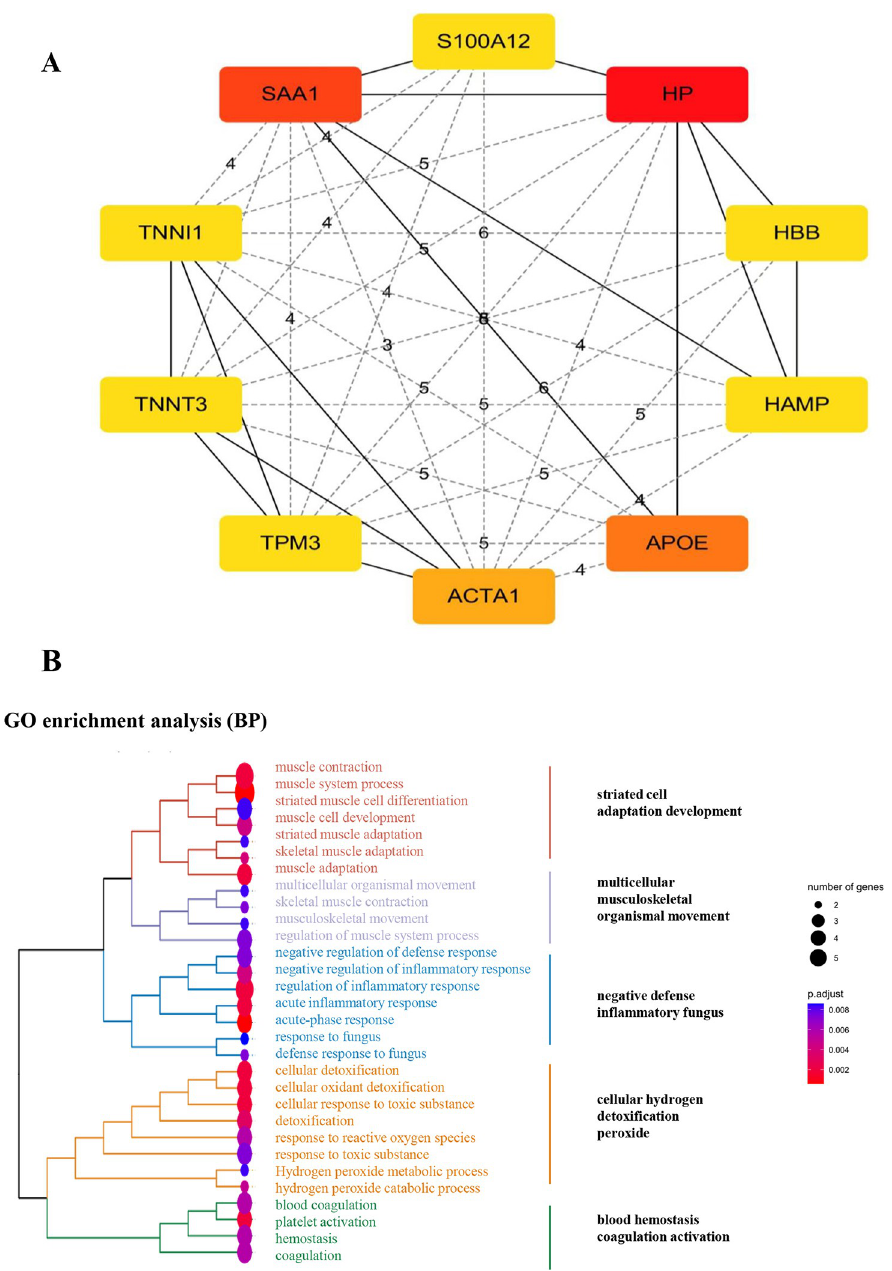
Fig 4. Identification of hug mRNAs. (A) It showed that 10 hub mRNAs with the highest degree identified according to the PPI network, which had critical roles in PPI network. (B) Functional prediction of hug mRNAs in PAH. analysed the GO terms of the hub mRNAs and found that they were predominantly concen- trated in striated cell adaptation development, multicellular musculoskeletal organismal move- ment, negative defense inflammatory fungus, cellular hydrogen detoxification peroxide and blood hemostasis coagulation activation (Fig 4B), which were highly consistent with the patho- physiological process of PAH.